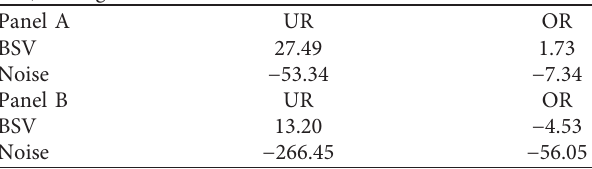
Figure 2: Graphic illustrations of the (a) underreaction (UR) and (b) overreaction (OR) trading strategies. Table 2: Profitability of the underreaction (UR) and overreaction (OR)